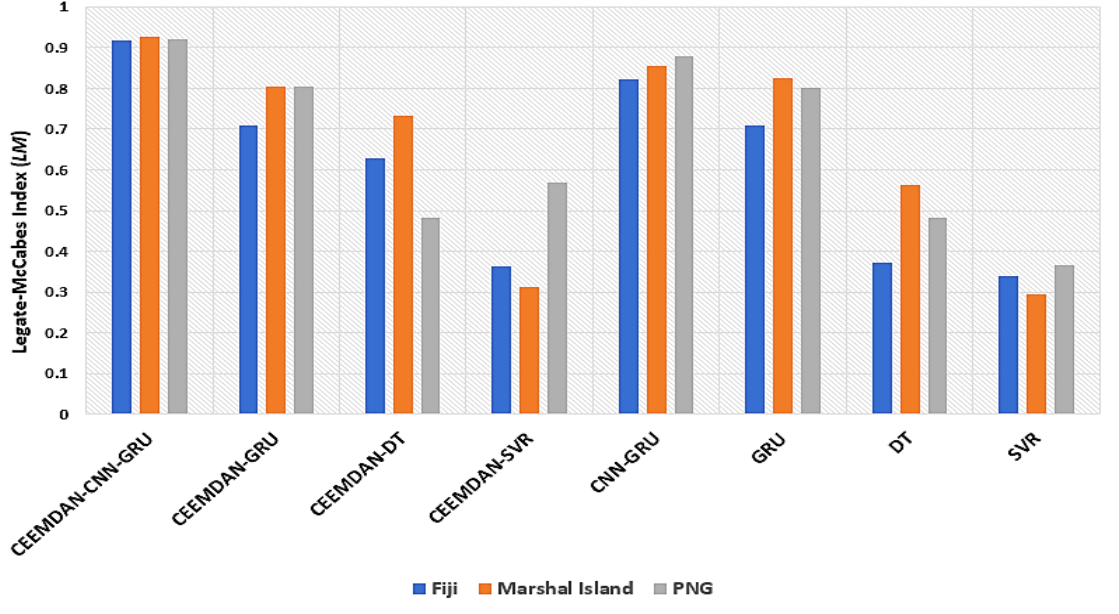
Figure 13. Bar graphs showing the Legate–McCabe’s Index (LM) with the proposed hybrid deep learning approach (CEEMDAN-CNN-GRU) in comparison with standalone models in the testing phase.